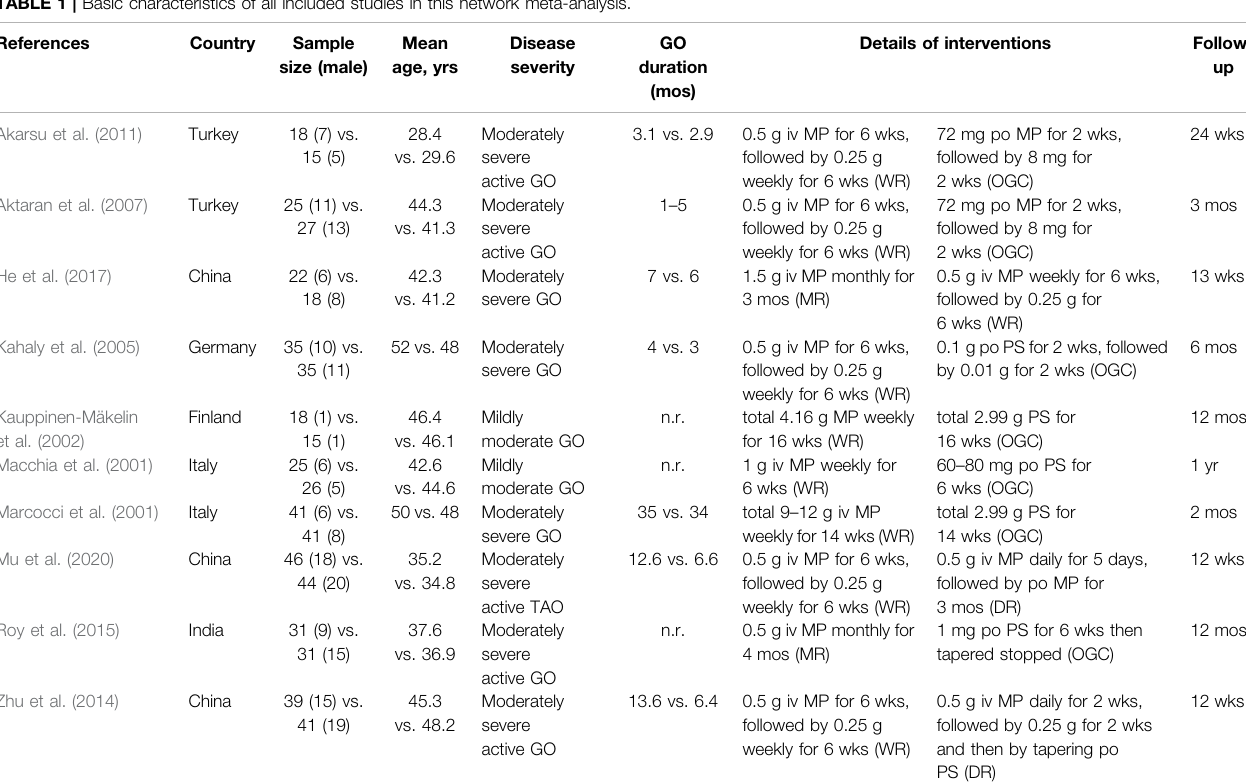
TABLE 1 | Basic characteristics of all included studies in this network